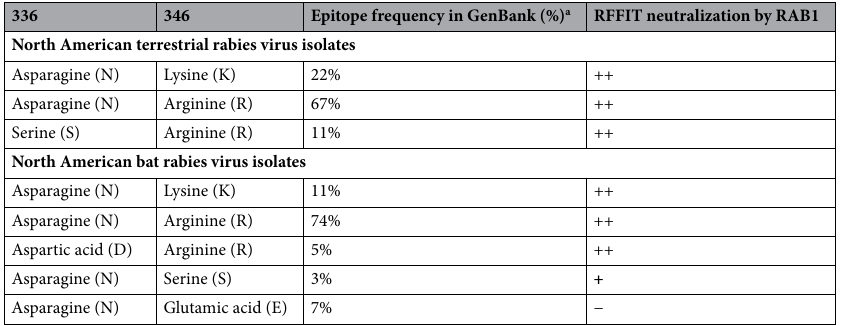
Table 1. RAB1 epitope analysis of North America rabies virus isolates. A total of 553 sequences was analyzed for North America RABVs including both terrestrial and bat isolates. ++EC 50 < 1 µg/mL. + EC 50 > 1 µg /mL. − Not neutralized by HuMAb at the highest concentration tested. a The occurrence frequency of RAB1 epitope with the noted residues at positions 336 and 346. Isolates with noted epitope variants were tested in